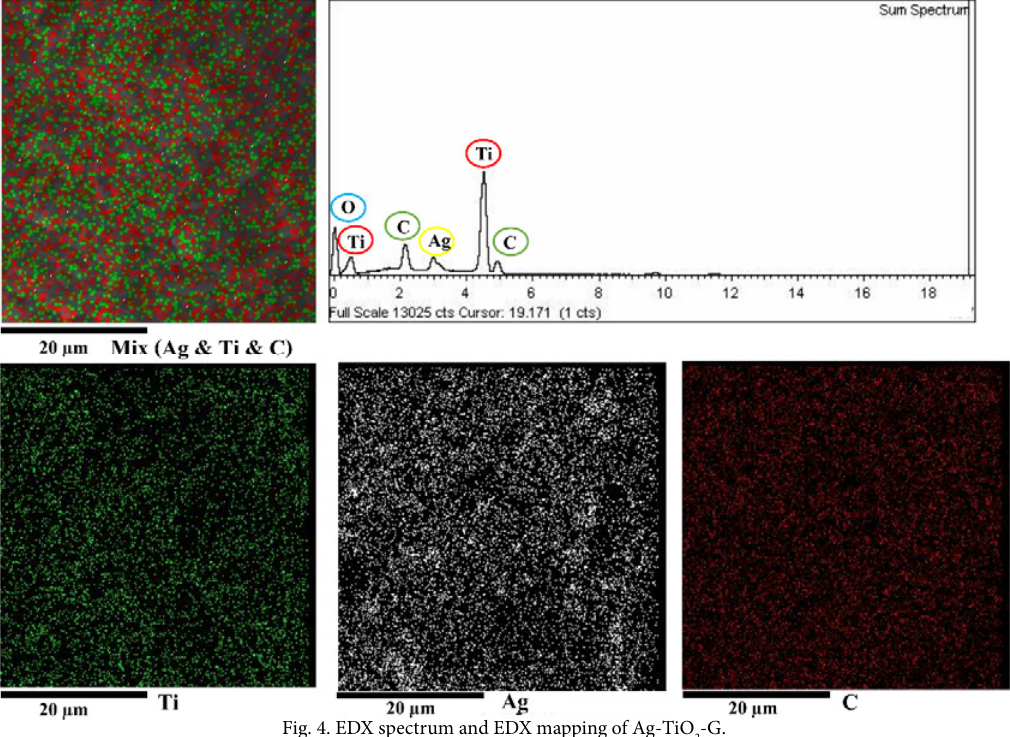
Fig. 4. EDX spectrum and EDX mapping of Ag-TiO